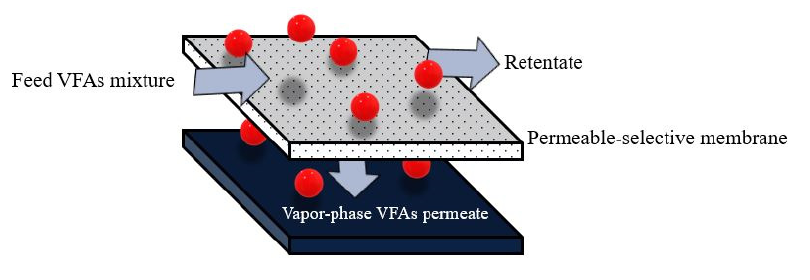
Figure 5. Schematic diagram of membrane pervaporation.